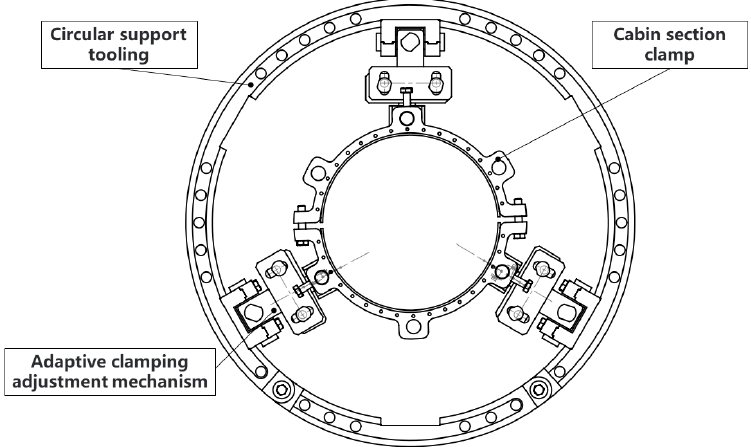
Figure 6. Circular